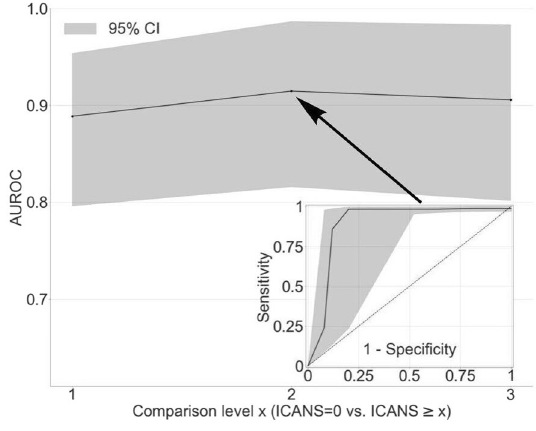
Figure 3. Area under the receiver operating curve for various comparison levels of ICANS. Plot showing how the VE-ICANS grading scale performs in discriminating patients without neurotoxicity (ICANS = 0) from those with neurotoxicity (ICANS ≥ x), for various levels of neurotoxicity, x. Here, discrimination is measured by area under the receiver operating characteristic curve (AUC). The shading indicates the 95% confidence